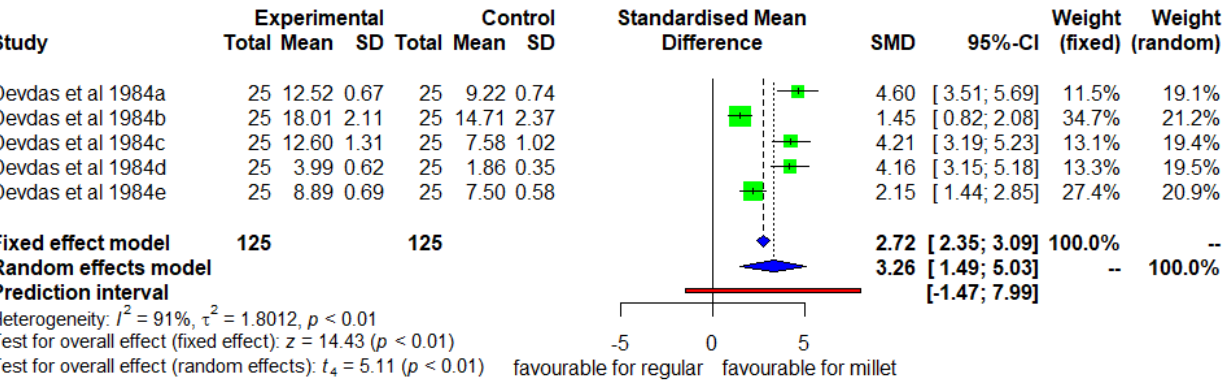
Figure 5. Effect of consuming a finger millet-based diet on mean change in chest circumference compared to a regular rice-based diet .